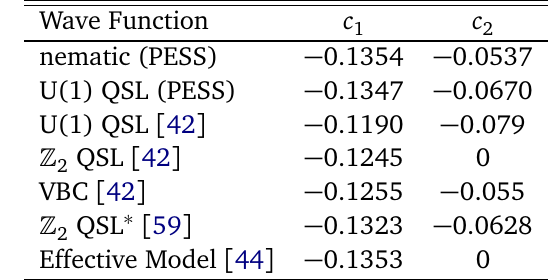
QSL ∗ of Ref. [ 59 ] . 2